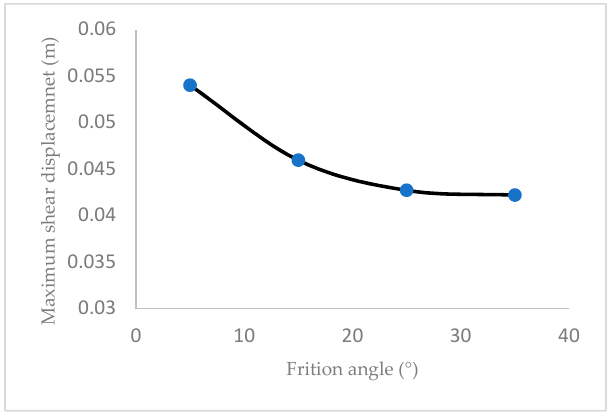
Figure 7. Effect of fault friction angle on the maximum shear displacement along shear zone.